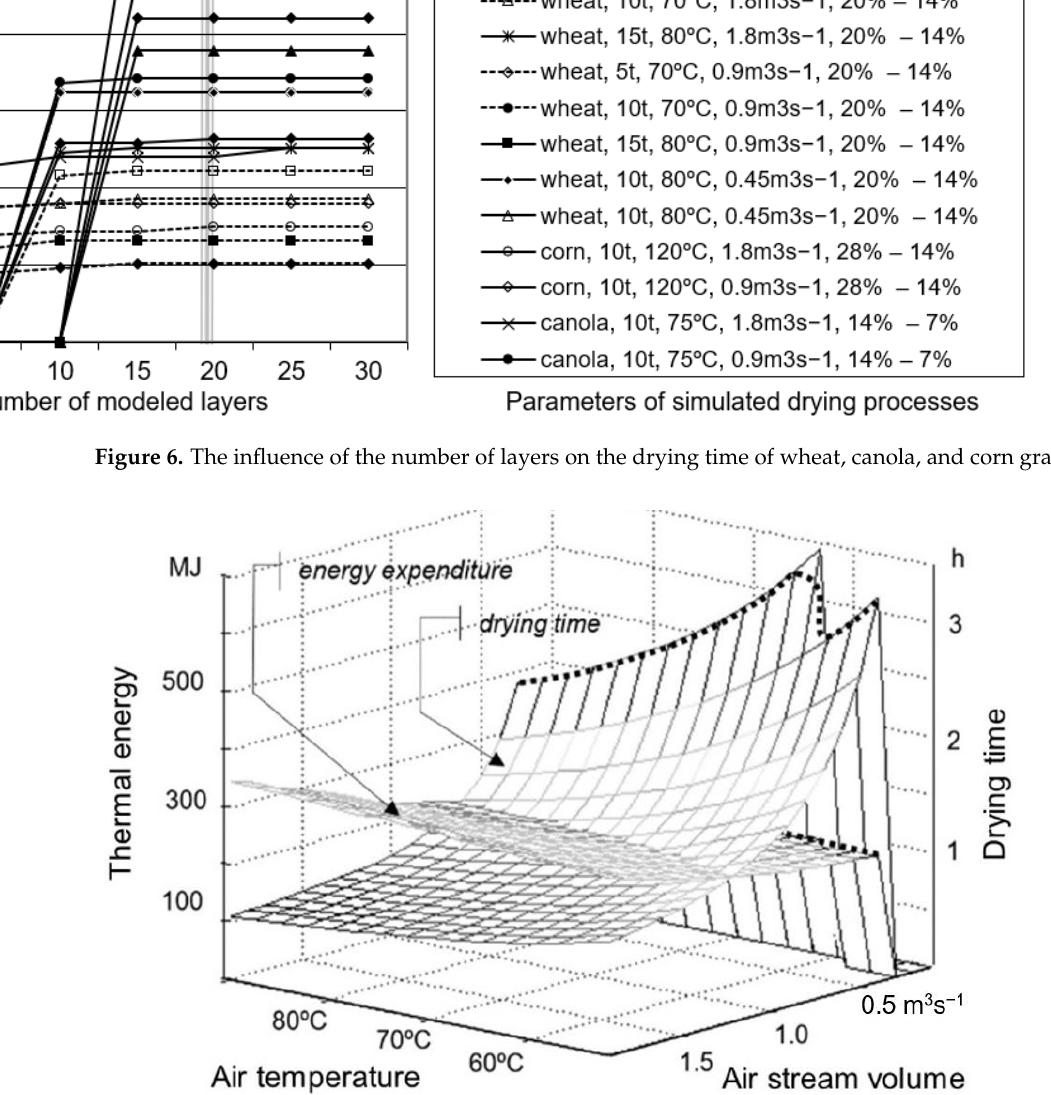
drying drying time.